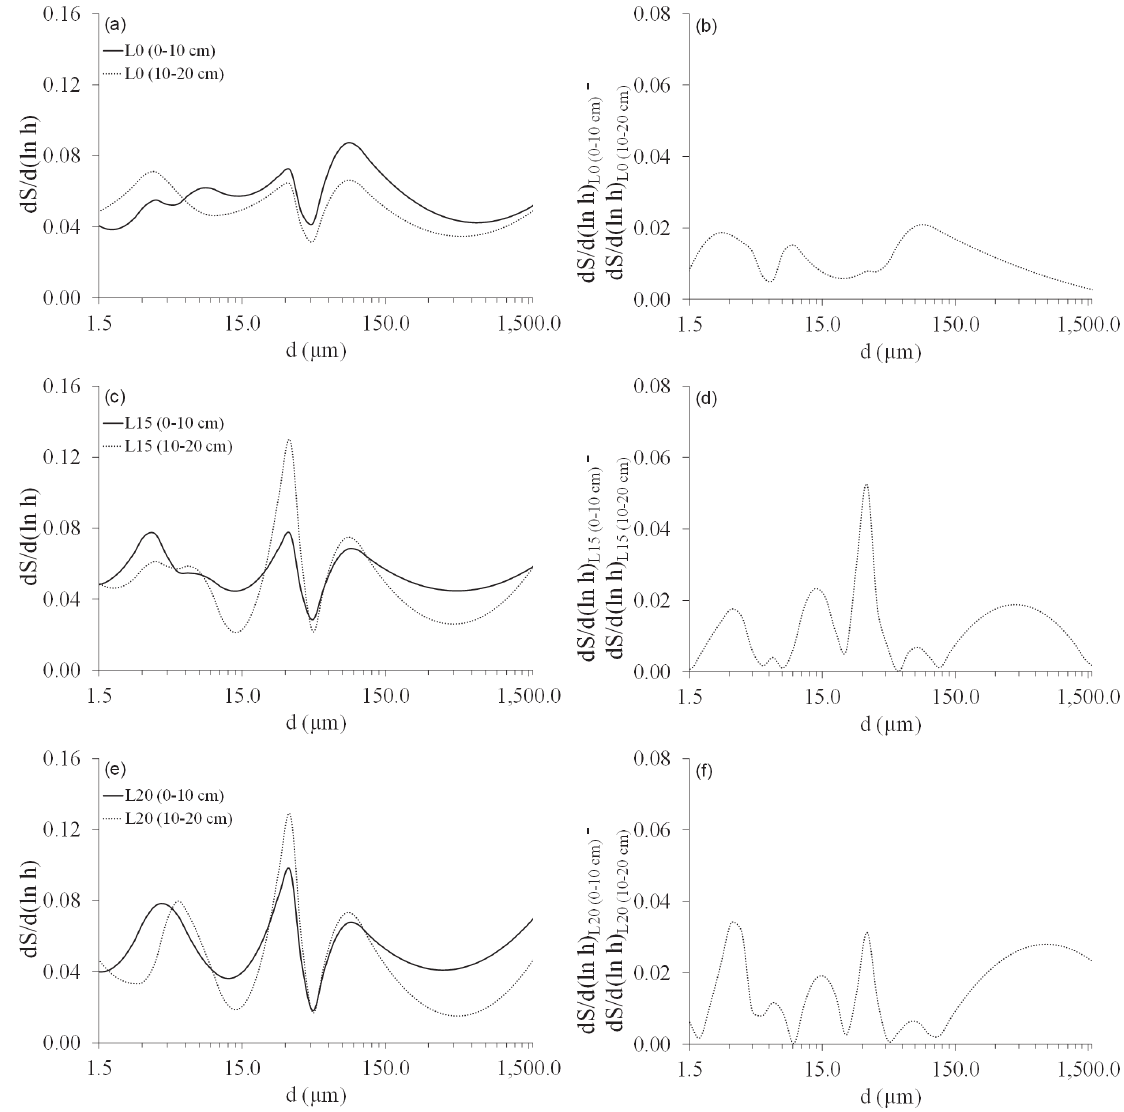
Figure 4 - Pore size distribution curves (PSDC) for 0-10 cm and 10-20 cm soil layers and the absolute difference between these curves for L0 ( a, b ), L15 ( c, d ), and L20 ( e, f ) treatments,